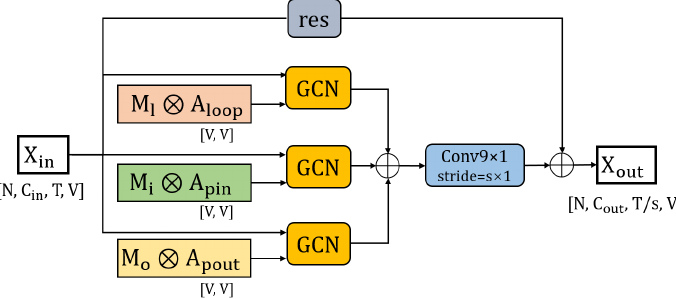
Figure 6. The structure of the PGCN unit. (cid:76) denotes the element-wise summation. (cid:78) represents the element-wise